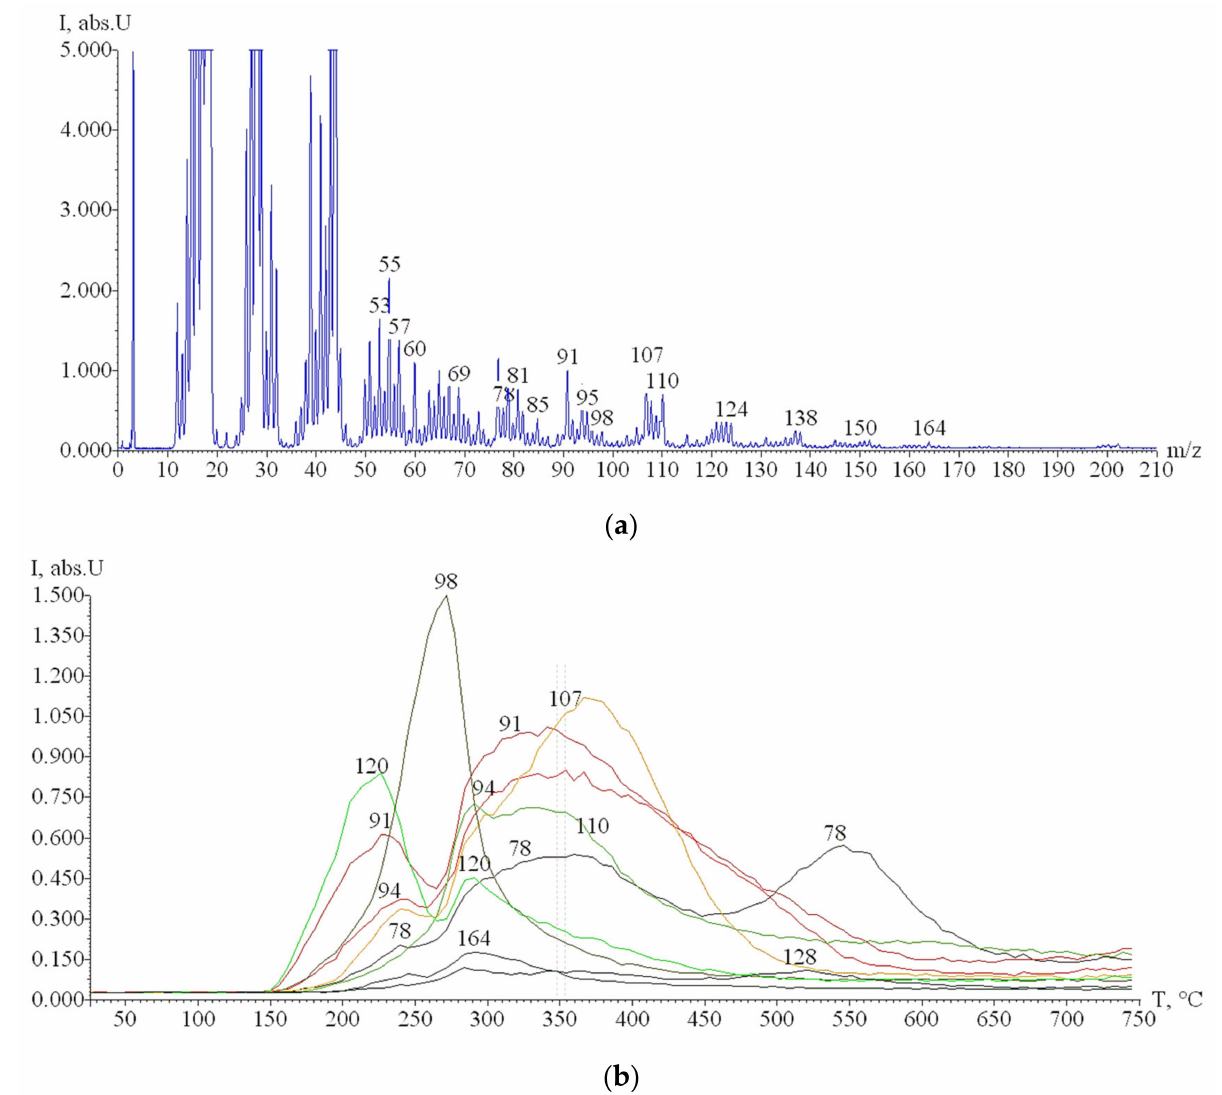
Figure 6. TPD-MS results: ( a ) mass spectrum of pyrolysis products of rice husk at 347 ◦ C obtained after electron impact ionization; ( b ) TPD-curves of the ions with m / z 164, 128, 120, 110, 107, 98, 94, 91, and 78 under pyrolysis of rice